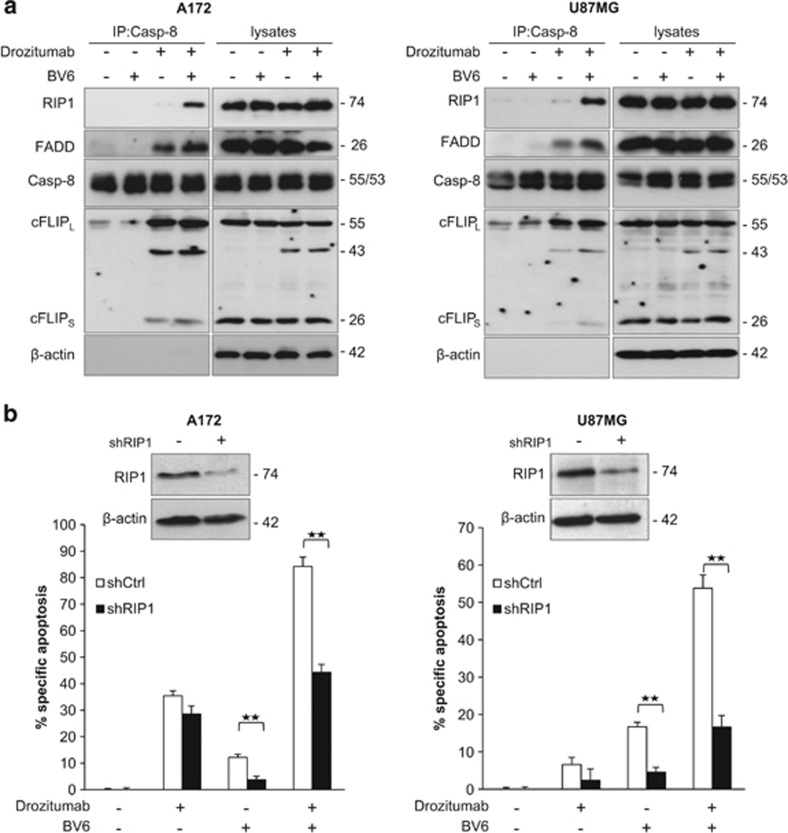
RIP1 is required for BV6- and Drozitumab-induced apoptosis. (a) A172 (left panel) and U87MG (right panel) cells were treated for 1 h with 0.3 μg/ml (A172) or 5 μg/ml (U87MG) Drozitumab and/or 3 μM (A172) or 4 μM (U87MG) BV6. Caspase-8 was immunoprecipitated (IP) using an anti-caspase-8 antibody and indicated proteins were detected by western blot analysis. A representative experiment of three independent experiments is shown. (b–d) A172 (left panels) and U87MG (right panels) cells were transduced with shRNA vector against RIP1 (shRIP1) or control vector (shCtrl). Expression of RIP1 was analyzed by western blotting (b, upper parts). Cells were treated for 72 h with 0.3 μg/ml (A172) or 5 μg/ml (U87MG) Drozitumab and/or 3 μM (A172) or 4 μM (U87MG) BV6 and apoptosis was determined by FACS analysis of DNA fragmentation of propidium iodide-stained nuclei (b, lower parts). In (c), A172 cells with RIP1 knockdown or control vector cells were treated for indicated times with 0.3 μg/ml Drozitumab and/or 3 μM BV6 and caspase activation was analyzed by western blotting. A representative experiment of two independent experiments is shown. (d) U87MG cells with RIP1 knockdown or control vector cells were treated for 72 h with 5 μg/ml Drozitumab and/or 4 μM BV6 and then seeded as single cells. Colony formation was assessed by crystal violet staining after 14 days and colonies were counted under the microscope. One representative experiment of three independent experiments (right panel) and the percentage of colony numbers compared with untreated control with mean + S.E.M. of three independent experiments performed in triplicate (**P<0.001) are shown (left panel). (e) A172 (left panel) and U87MG (right panel) cells were treated for 72 h with 0.3 μg/ml (A172) or 5 μg/ml (U87MG) Drozitumab and/or 3 μM (A172) or 4 μM (U87MG) BV6 in the presence or absence of 30 μM necrostatin-1 (Nec-1). Apoptosis was determined by FACS analysis of DNA fragmentation of propidium iodide-stained nuclei. Mean + S.E.M. of three independent experiments performed in triplicate are shown